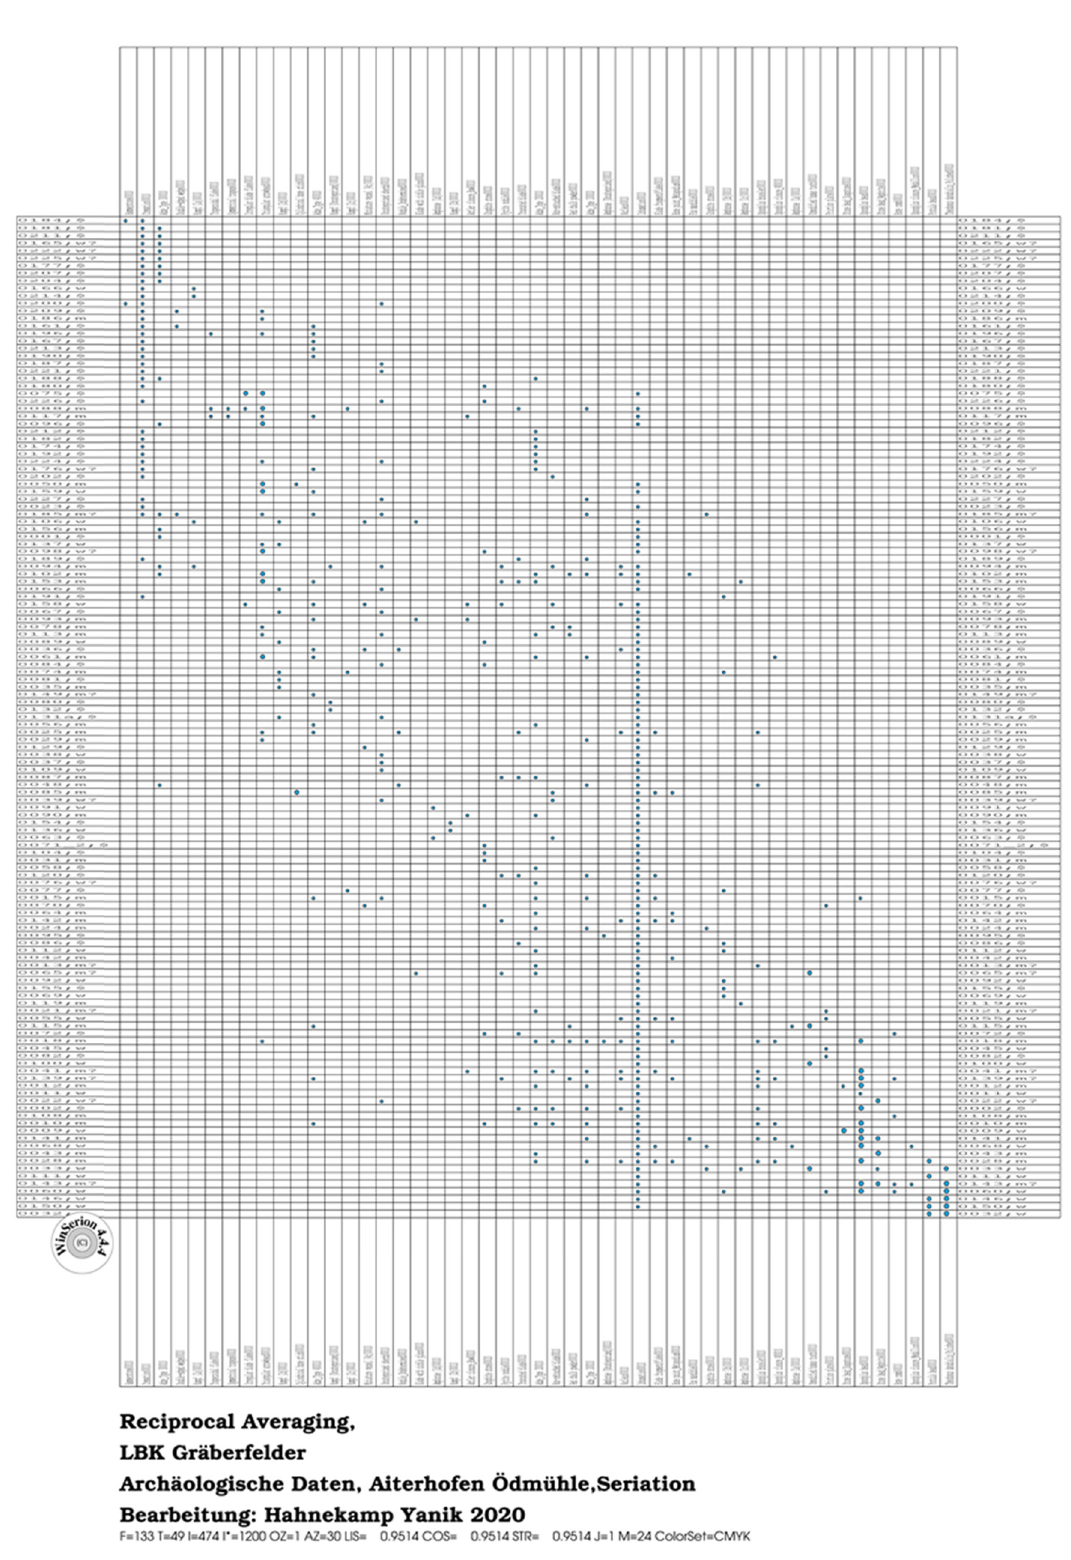
Figure 6: Seriation of the data set of grave goods combined with burial types of Aiterhofen - Ödmühle ( Hahnekamp, 2020, p. 386, Figure App. 80 )